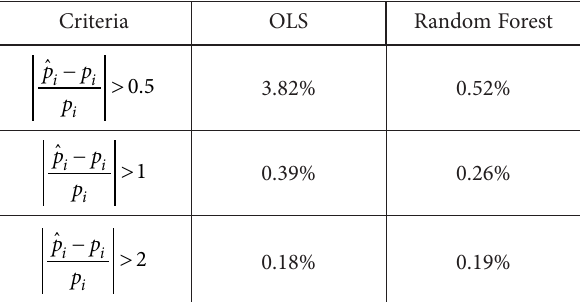
Table 7. Proportion of outliers (average of 10 trials)